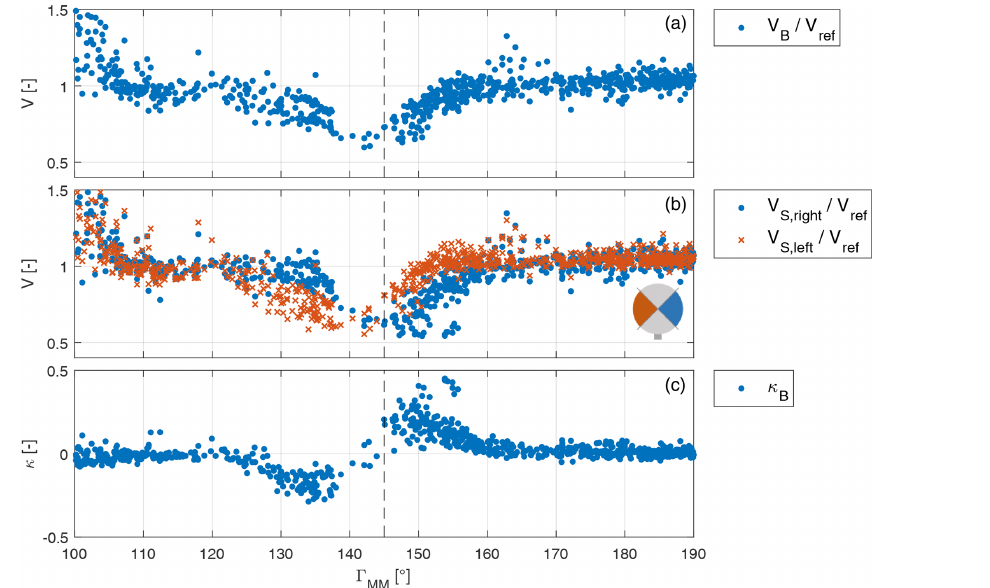
Figure 13. Wind speeds and shear at the WT1 rotor disk as functions of wind direction. (a) Nondimensional load-based rotor-effective wind speed. (b) Left and right sector-effective wind speeds. (c) Horizontal shear.